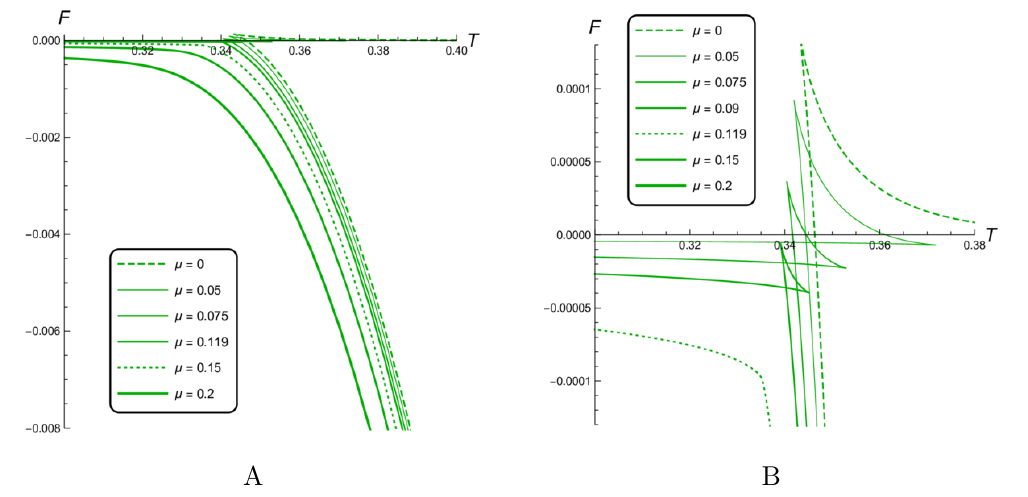
Figure 27 . The black hole free energy F ( T ) for c = (cid:0) 1 and di(cid:11)erent (cid:22) in isotropic case (A) and its zoom near F = 0